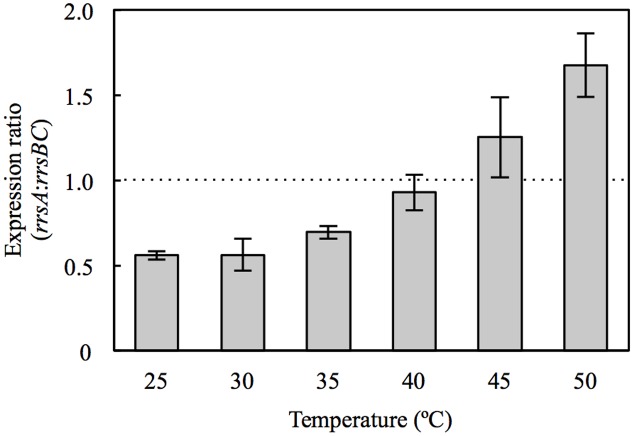
Expression ratio of rrsA to rrsBC in Haloarcula hispanica cultured at 25, 30, 35, 40, 45, and 50°C. Error bars denote standard deviation of mean values for triplicate measurements. The dashed line indicates rrsA:rrsBC ratio of 1.0.